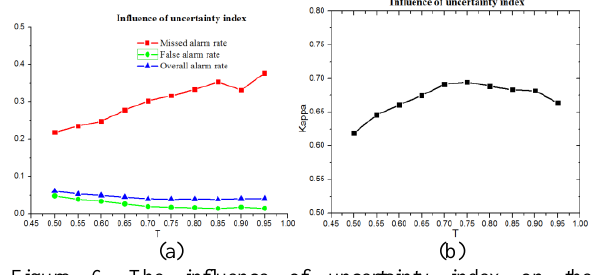
Figure 6. The influence of uncertainty index on the experimental dataset. Influence of uncertainty index (a) on FA, MA and OE; (b) on kappa index.